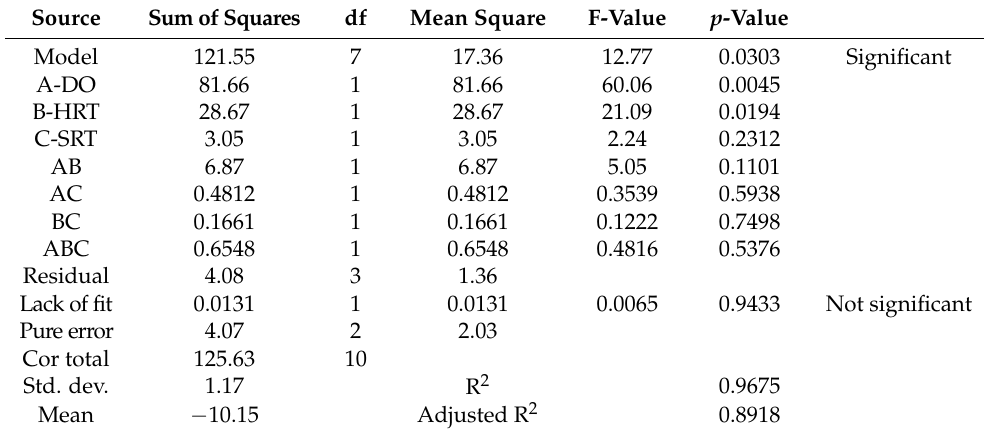
Table 7. ANOVA results for phosphorus removal response.